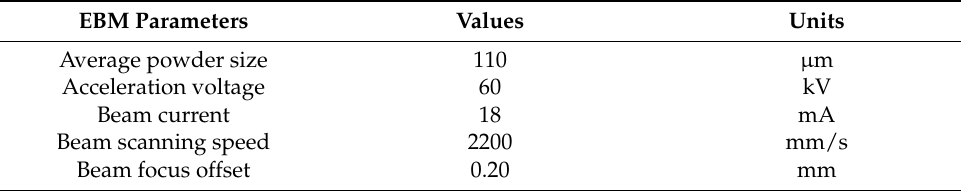
Table 1. EBM parameters employed for specimen